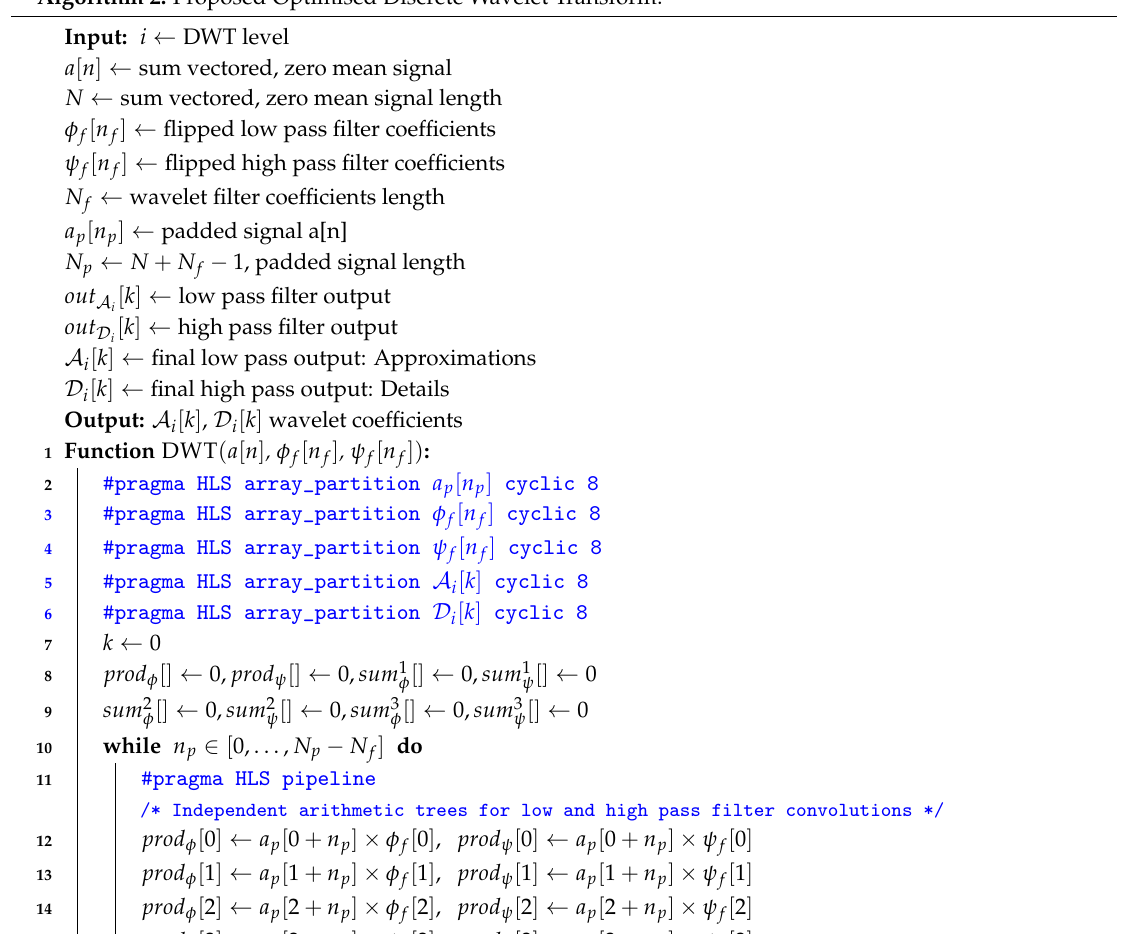
Algorithm 2: Proposed Optimised Discrete Wavelet